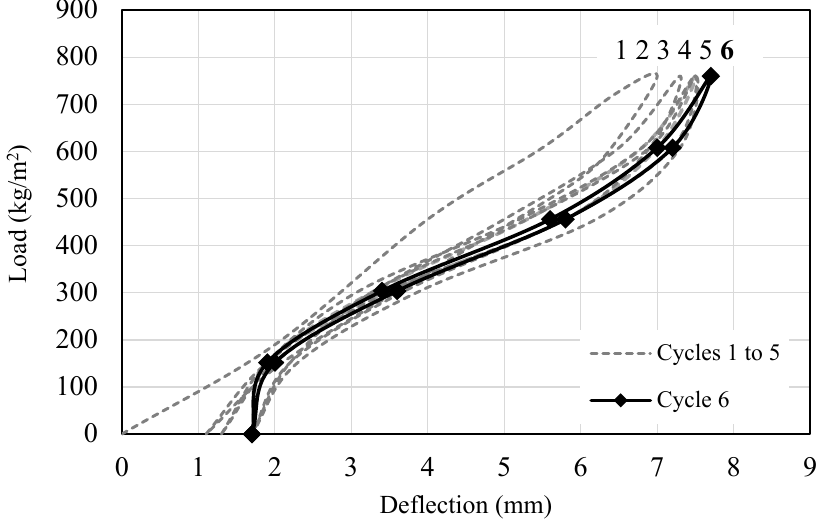
Figure 13. Overview of the loading and unloading process (several cycles).